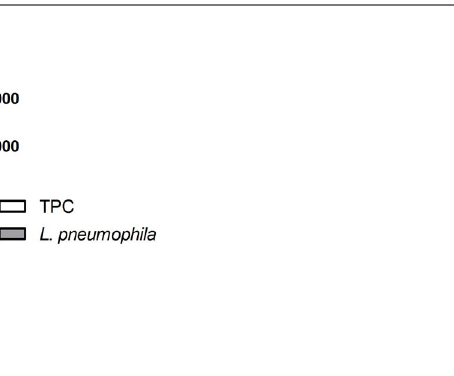
Fig. 6. Comparison between TPC and L. pneumophila in selected buildings of the surveillance pilot study. SC 5 sports complex, NH 5 nursing home, S 5 school. The stippled lines at 1000 and 10000 cfu/ml show the two TPC limits of action with regard to measures against L. pneumophila practiced by Stavanger municipality during the first part of the project